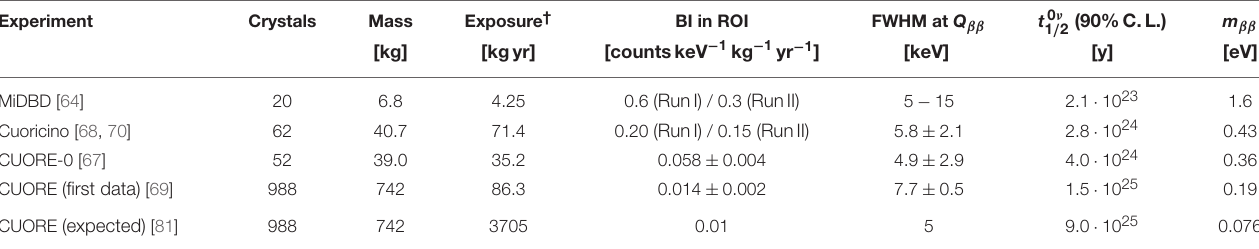
TABLE 2 | Main characteristics of the TeO 2 bolometric experiments searching for the 0 νββ of 130 Te. Experiment